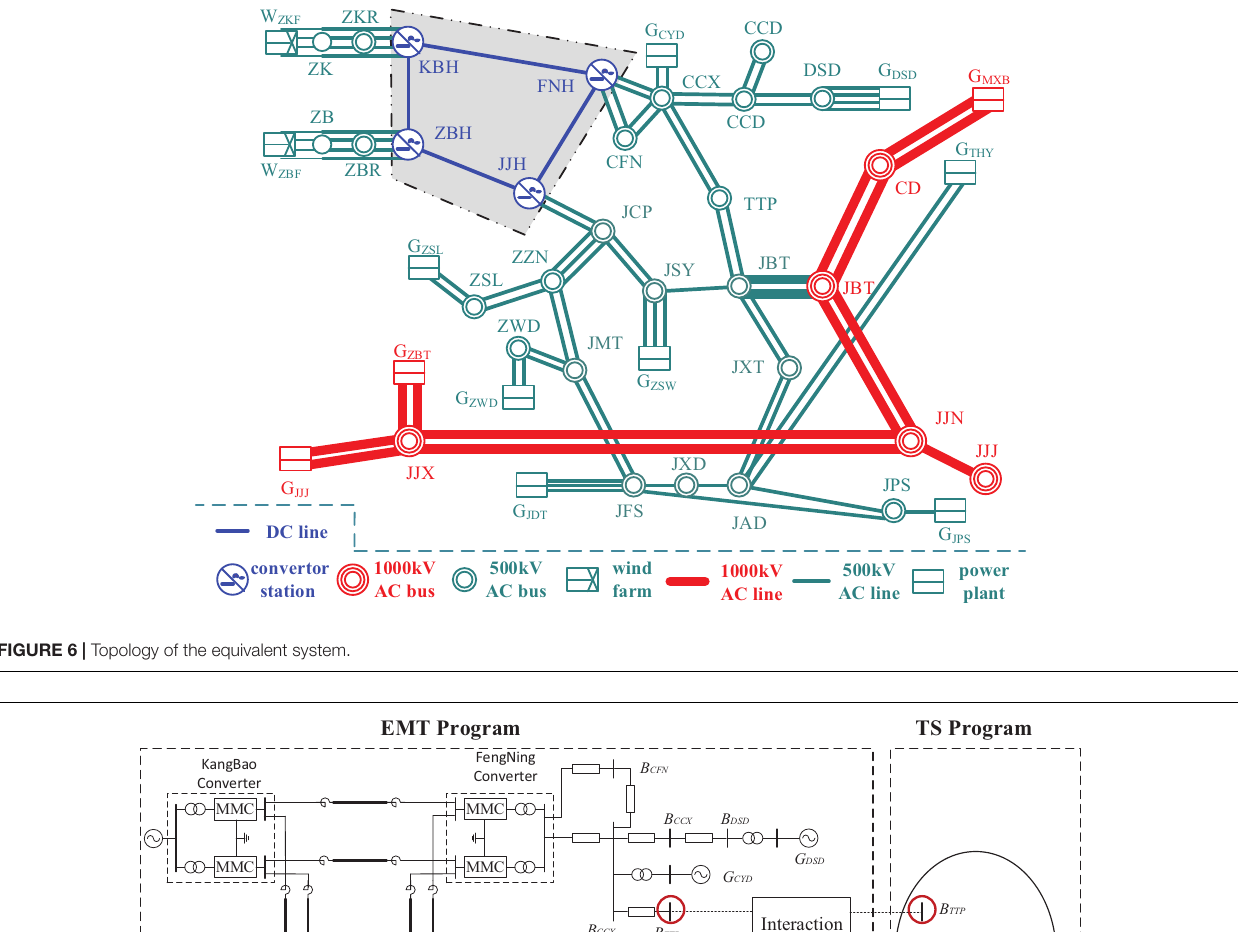
FIGURE 7 | Decomposition in the TS and EMT